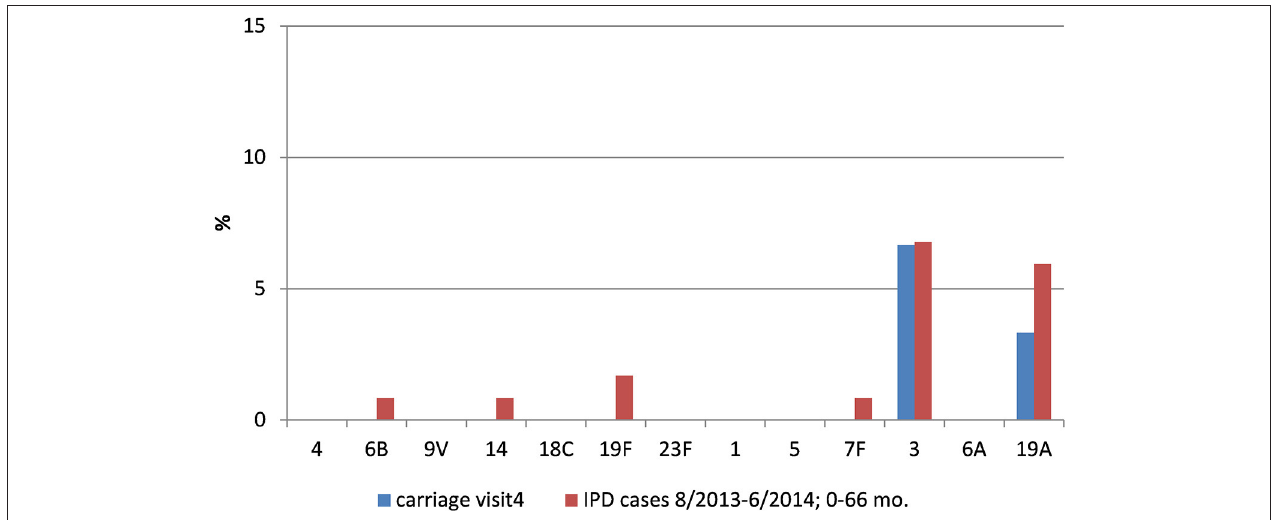
FIGURE 4 | Pneumococcal vaccine-type carriage in our study population and IPD data from comparable age groups.